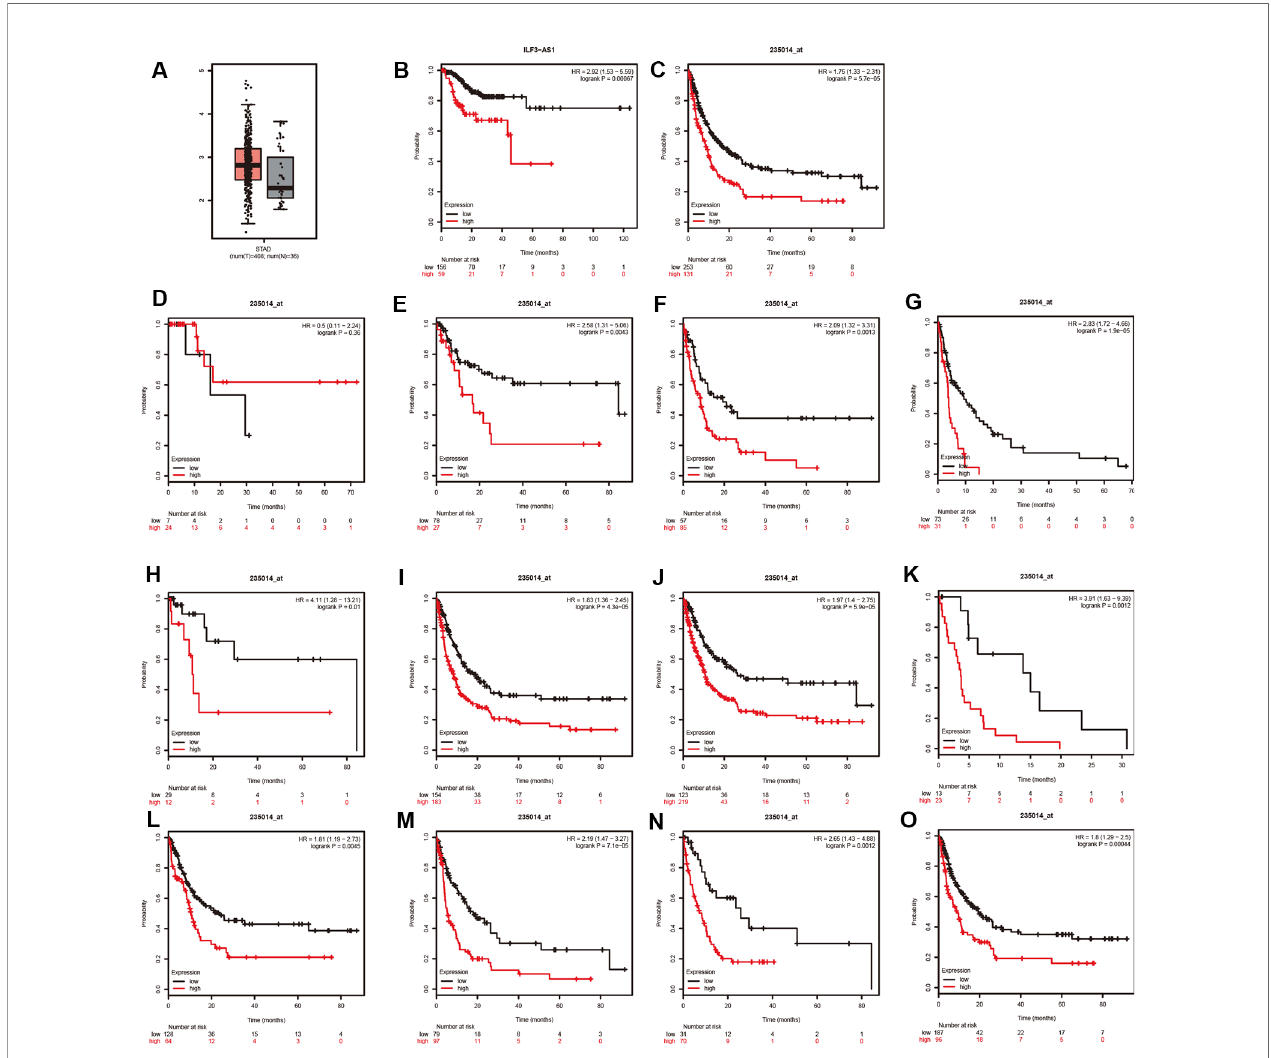
FIGURE 4 | ILF3-AS1 Expression in GC and Correlates with disease free survival of GC. (A) The boxplot of ILF3-AS1 expression in GC between 408 tumor samples and 36 normal samples. (B, C) Higher expression levels of ILF3-AS1 correlates with disease free survival of GC using TCGA (B) and Kaplan – Meier plotter database (C) . (D – O) ILF3-AS1 expression was correlated to the disease free survival of patients with Stage 1 (D) , Stage 2 (E) , Stage 3 (F) , Stage 4 (G) , N0 (H) , N1+2+3 (I) , M0 (J) , M1 (K) , intestinal (L) , diffuse (M) , HER2 positive (N) and HER2 negative (O)